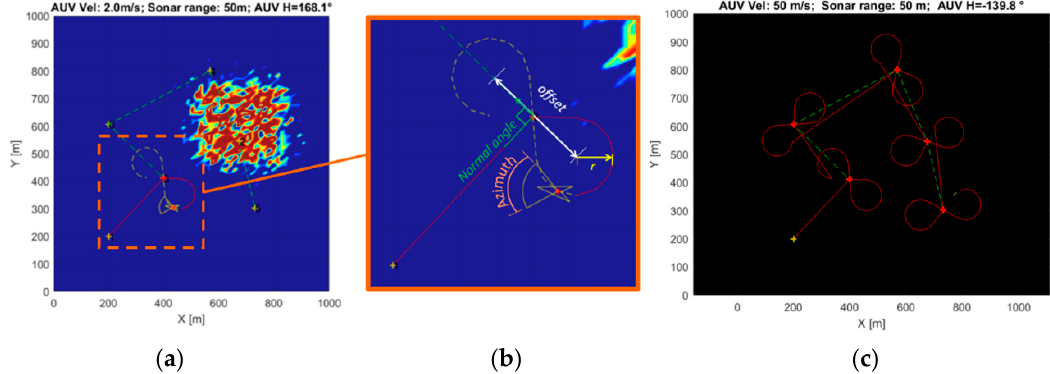
Figure 7. The proposed bumblebee flight survey was executed on arrival at a waypoint ( a , b ). A full AUV trajectory is shown where no oil plume is detected ( c ). The green dotted line indicates the planned AUV trajectory. The red line corresponds to the actual AUV trajectory on performing the bumblebee flight.